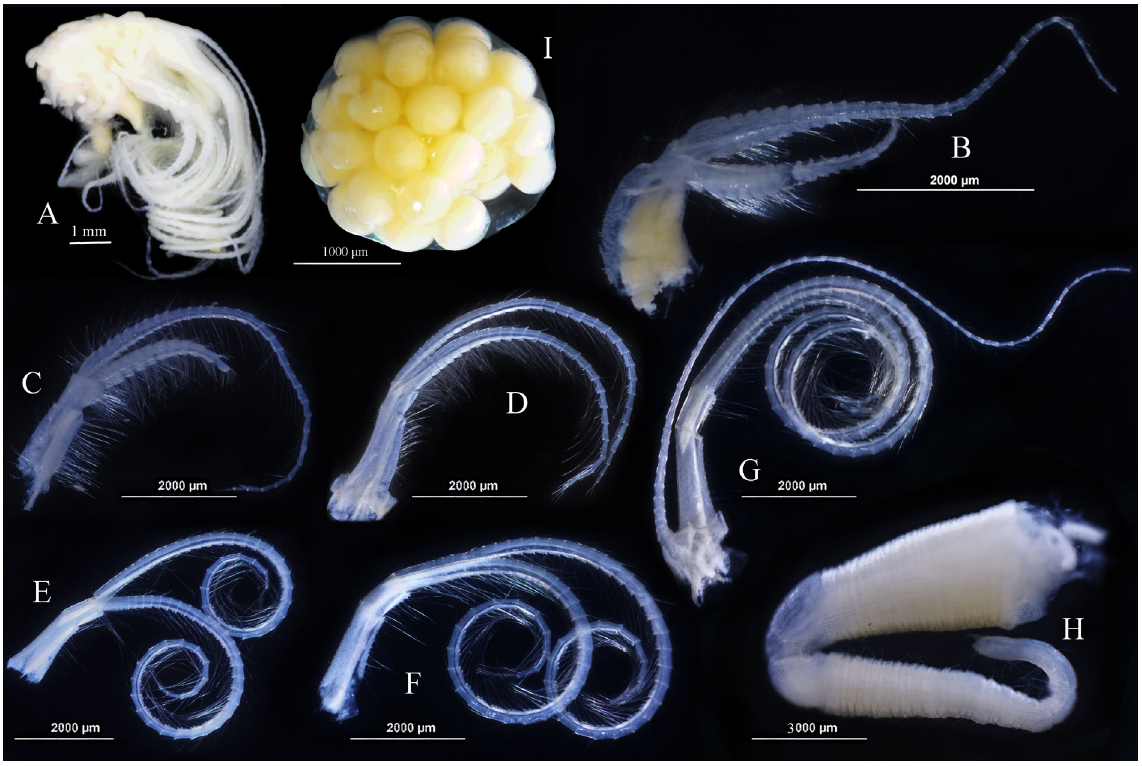
Fig. 3. Gibbosaverruca weijiai sp. nov., holotype, SRSIO17090313. A . Soft body. B . Cirrus I. C . Cirrus II. D . Cirrus III. E . Cirrus IV. F . Cirrus V. G . Cirrus VI. H . Penis. I .